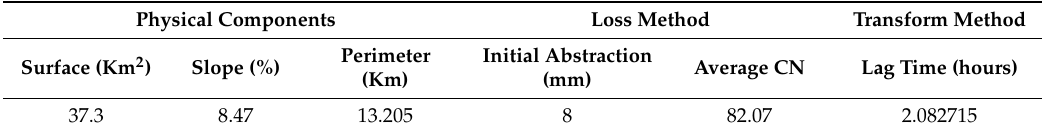
Table 2. Hydrologic characteristics of the KALAYA